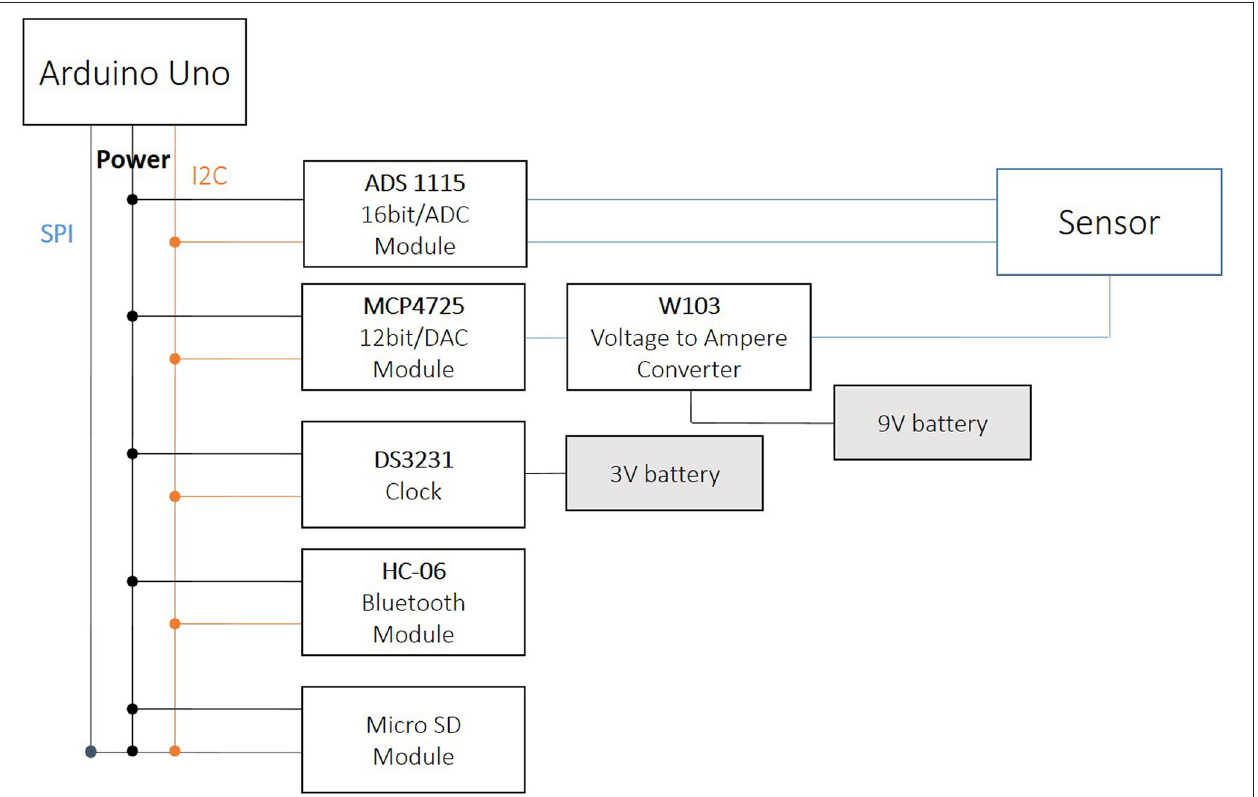
FIGURE 11 | Schematic of the wireless chloride ion sensing system based on Arduino Uno.